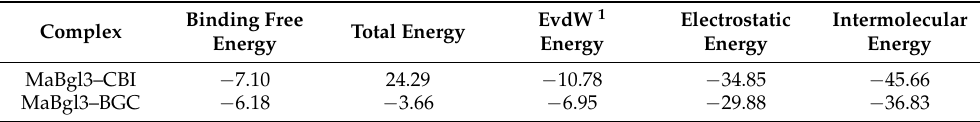
Table 4. Summary of DockThor results. All results are reported in